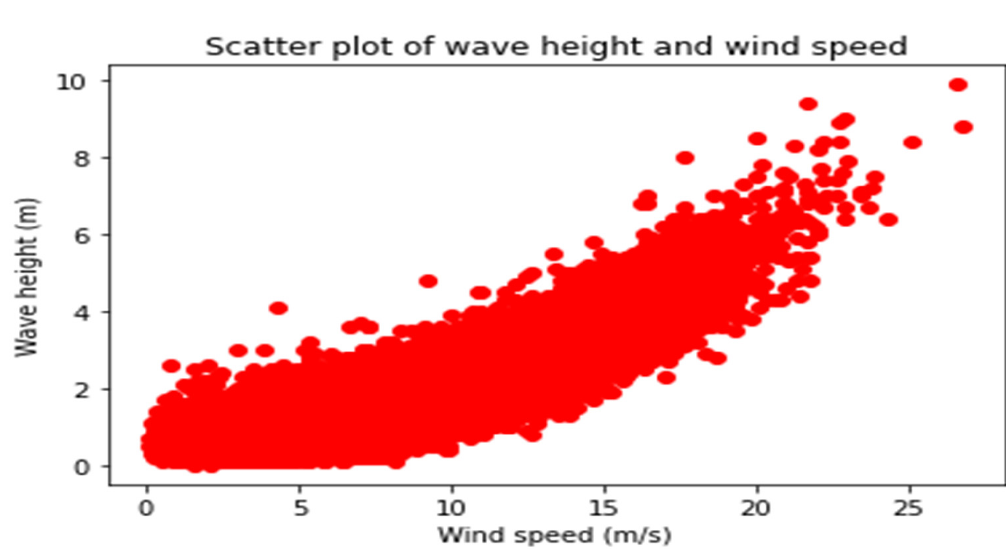
Figure 5. Scatter plot between wave height and wind speed.